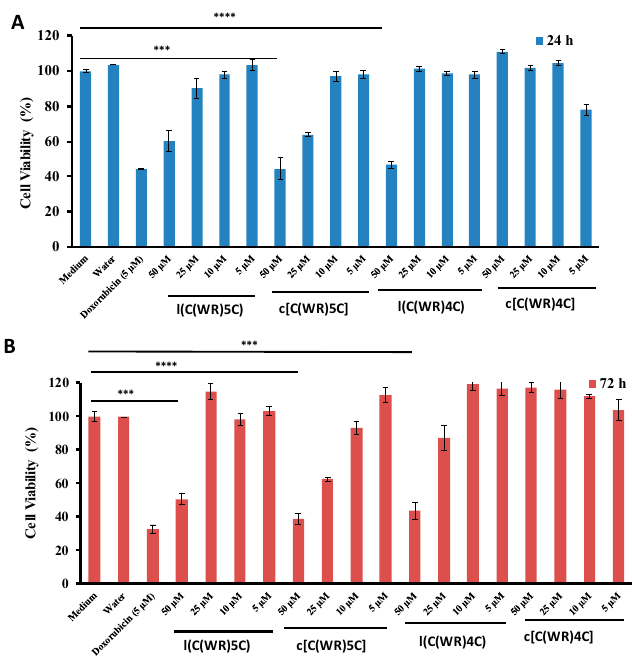
Figure 2. MTS assay of peptides (5–50 µ M) on LLC-PK1 cell lines. ( A ) 24 h incubation and ( B ) 72 h incubation ( n = 3) (if p < 0.05 then *, if p < 0.01 then **, if p < 0.001 then ***, if p < 0.0001 then ****). Error bars are SD.